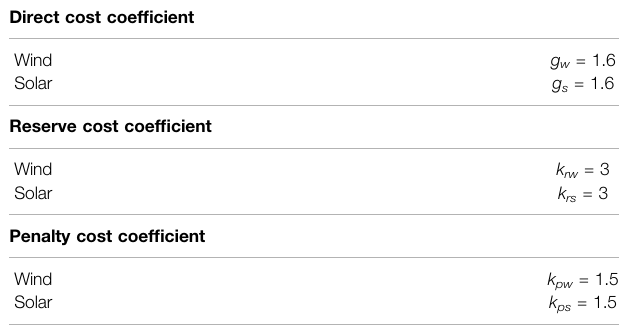
TABLE 4 | Cost coef fi cients for A and B fuels (Biswas et al., 2018). Units Bus #